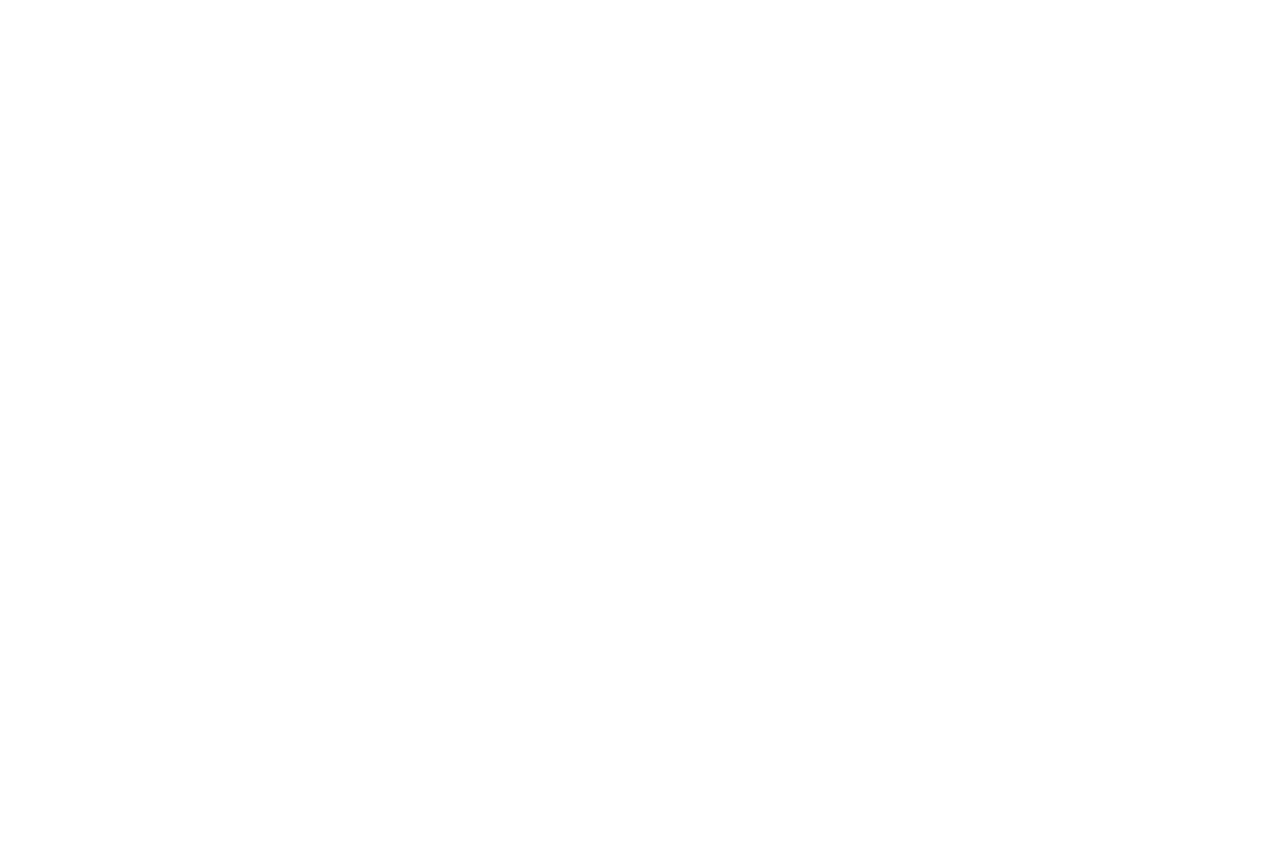
Frontiers in Genetics |